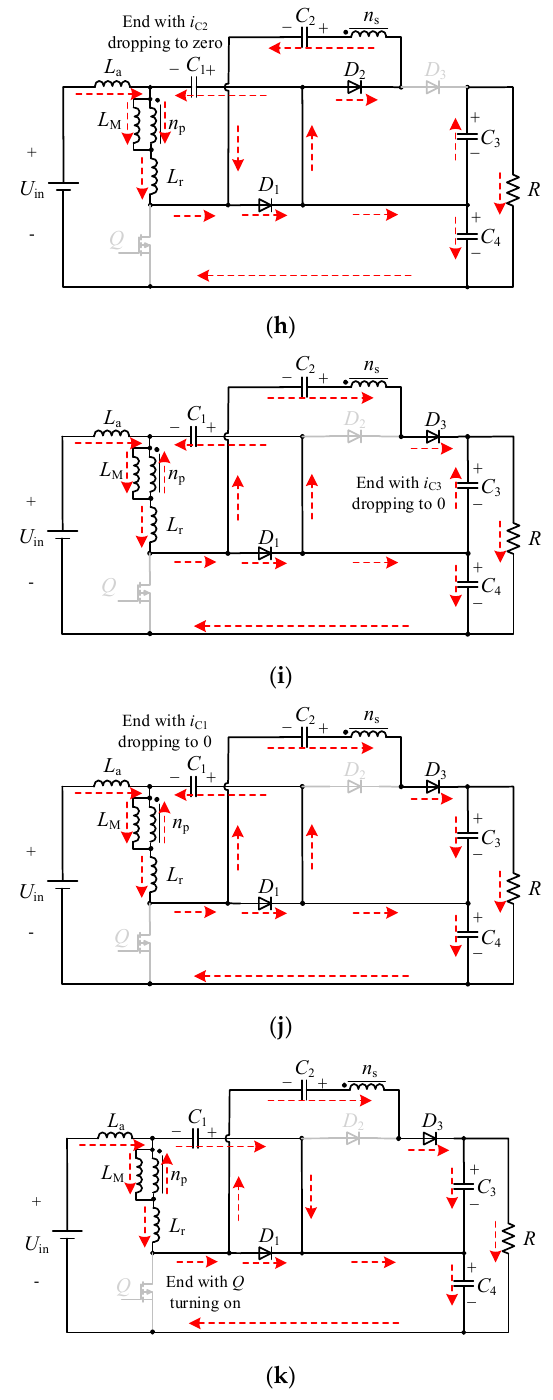
Figure 2. Current flow paths of the proposed converter in one switching period. ( a ) Mode A; ( b ) Mode B; ( c ) Mode C; ( d ) Mode D; ( e ) Mode E; ( f ) Mode F; ( g ) Mode G; ( h ) Mode H; ( i ) Mode I; ( j ) Mode J; ( k ) Mode K.